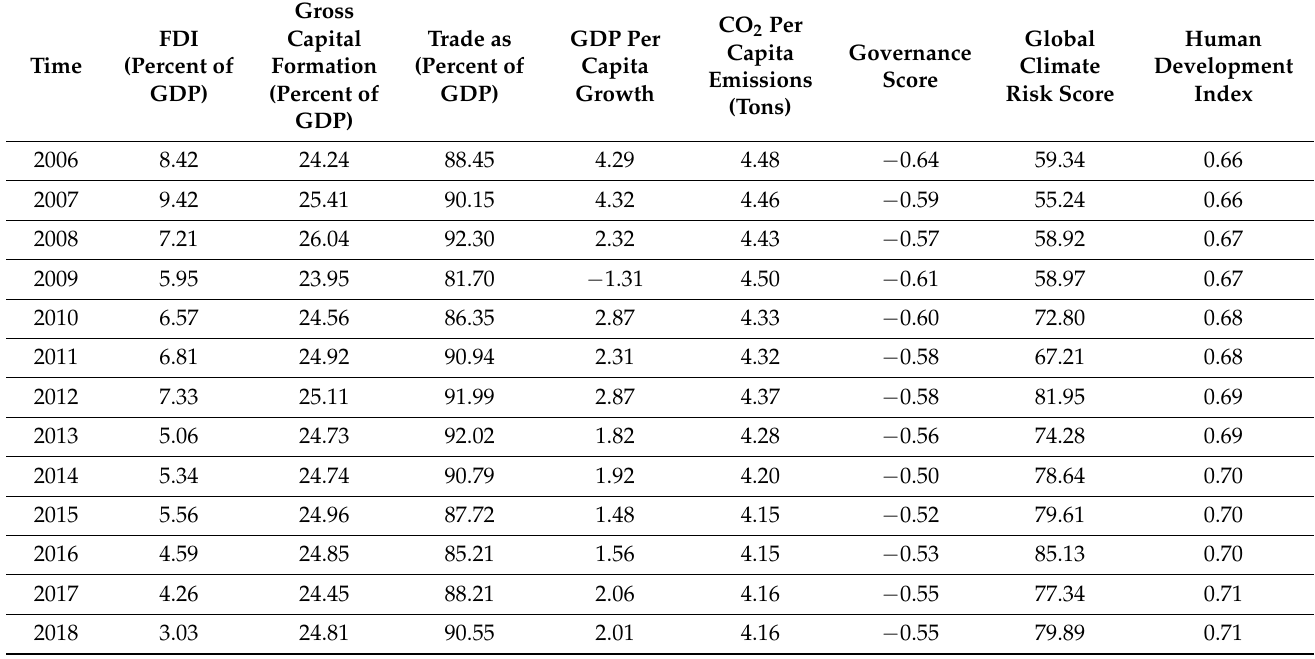
Table 1. Descriptive statistics for countries from